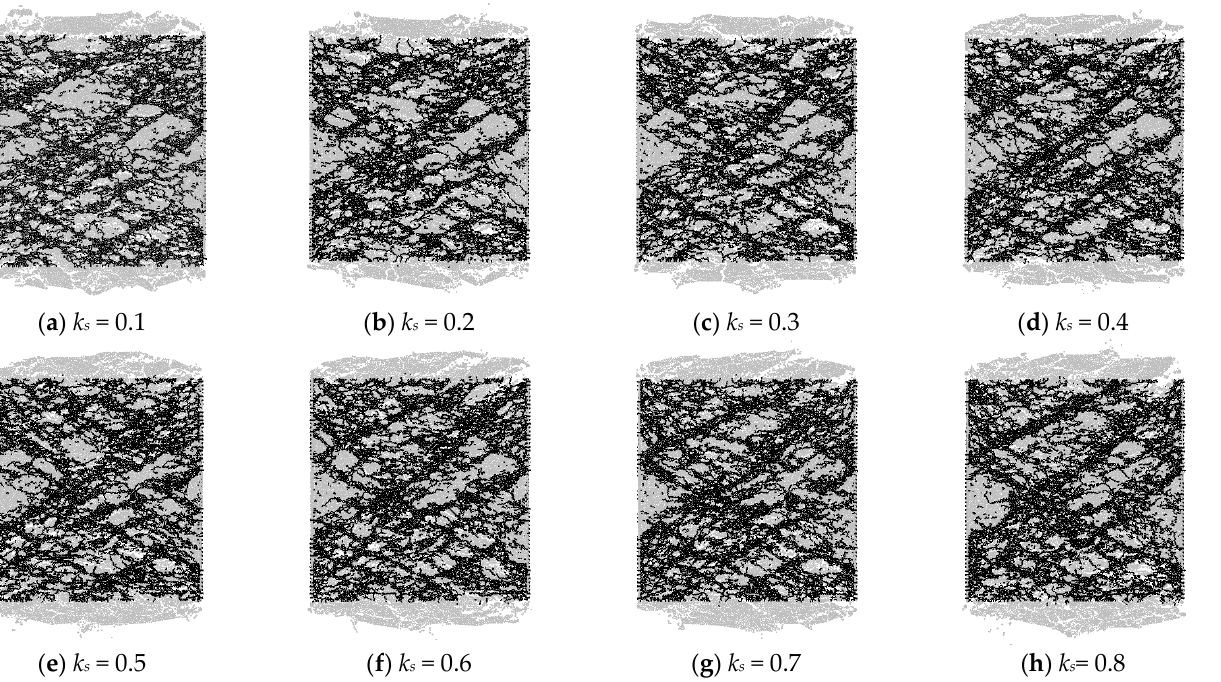
Figure 10. Failure mode of sample subject to different pre-stress levels at 8 m/s impact speed.